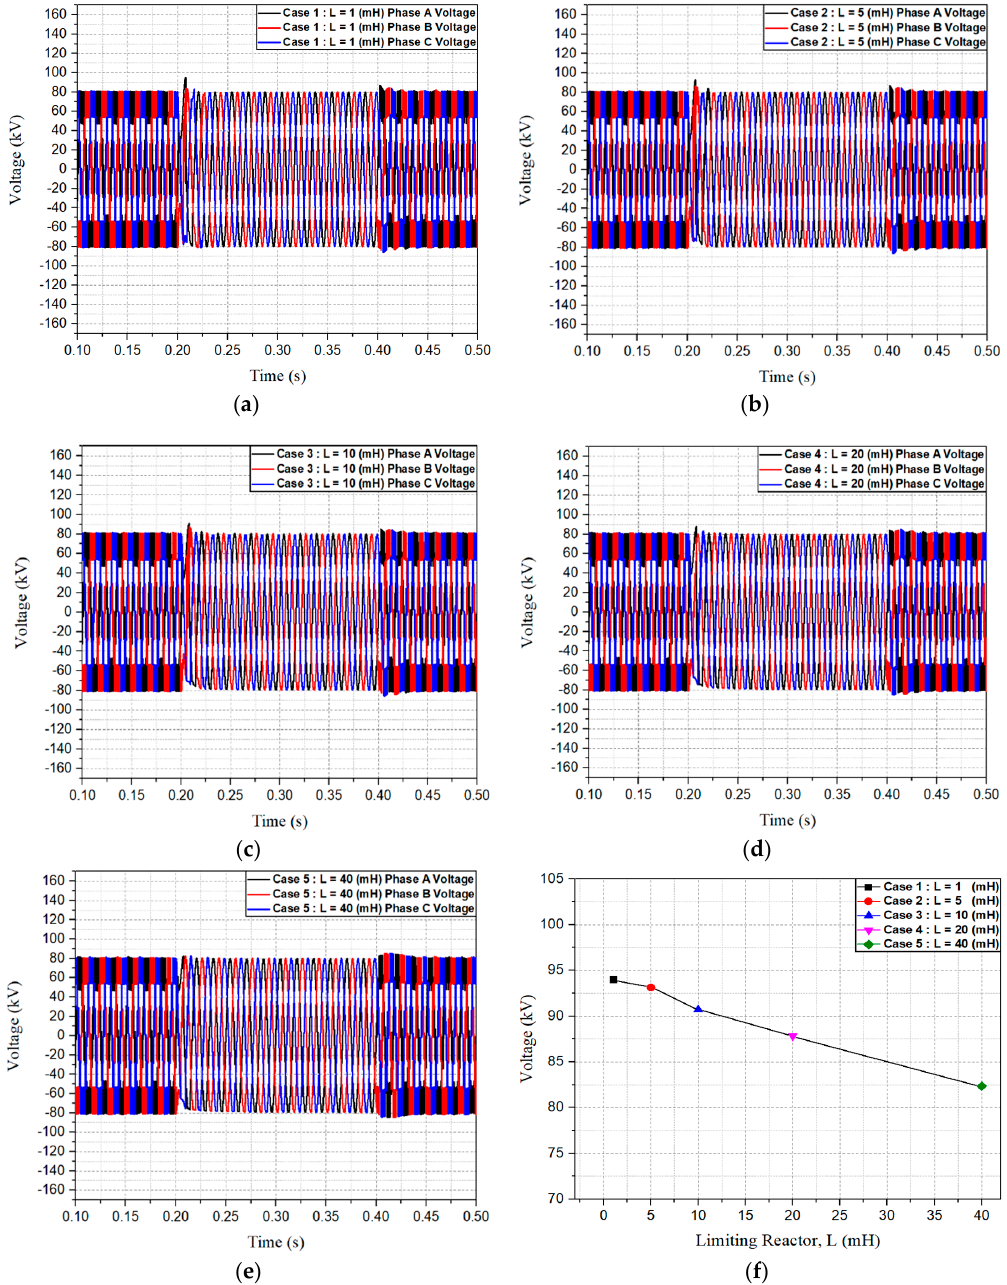
Figure 9. The transient voltage waveforms of the AC system considering the variable current limiting reactor: ( a ) Case 1: L = 1 (mH); ( b ) Case 2: L = 5 (mH); ( c ) Case 3: L = 10 (mH); ( d ) Case 4: L = 20 (mH); ( e ) Case 5: L = 40 (mH); ( f ) comparison of maximum overvoltage in transient state.